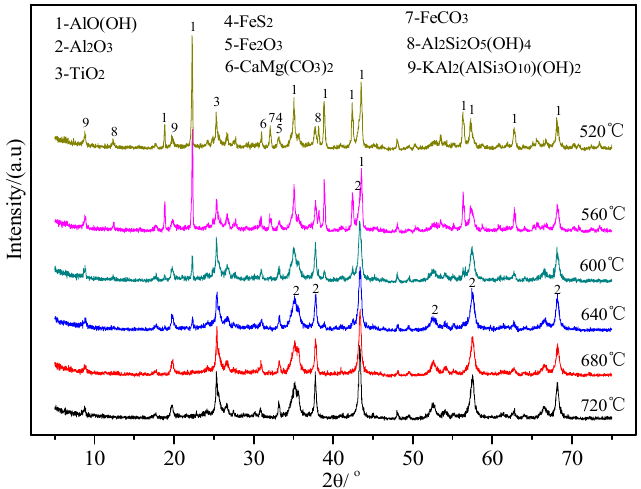
Figure 7. XRD patterns of ore roasted at different temperatures.